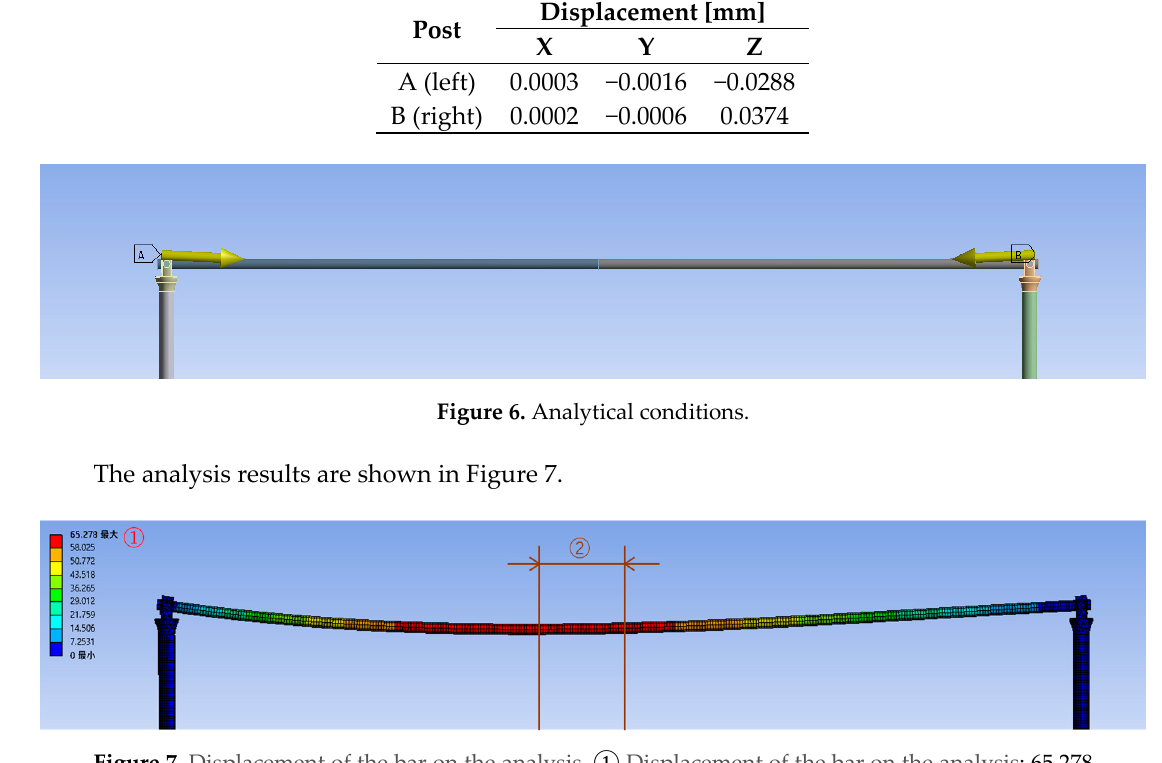
Figure 7. Displacement of the bar on the analysis. ① Displacement of the bar on the analysis: 65.278 mm. ② Distance from the center position of the bar to the maximum deflection position: 229.36